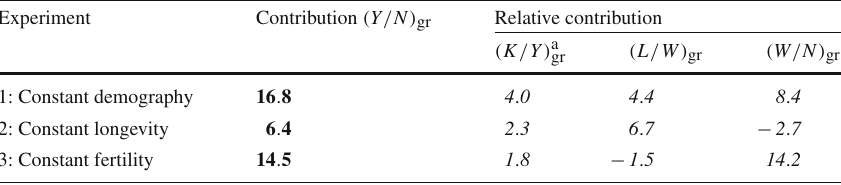
Table 4 Demographic contribution to the growth rate of per-capita output ( Y / N ) gr from 1850 to 2000 by demographic component (in percent) Source Authors’ estimates based on Table 3 Experiment Contribution ( Y / N )